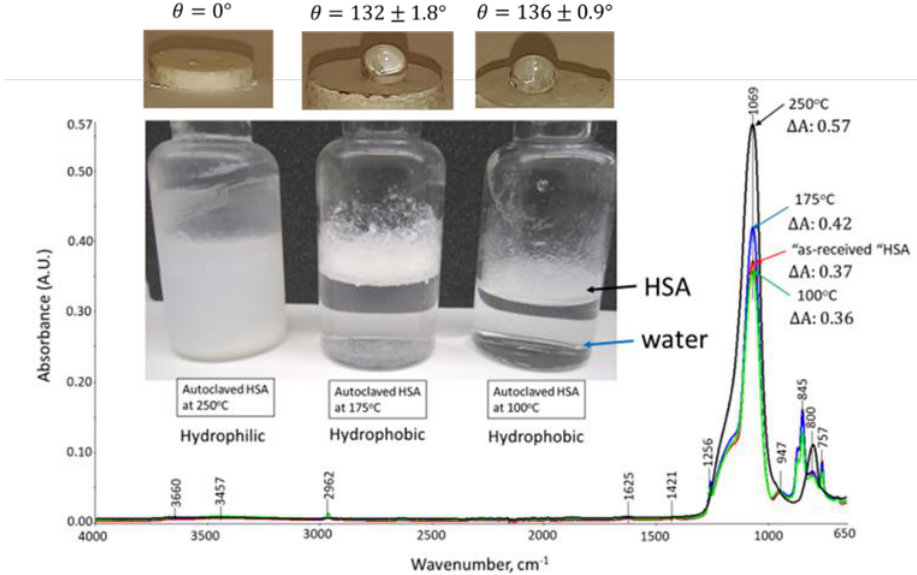
Figure 3. Visual characteristics, water repellency, and ATR-FTIR analyses for 100, 175, and 250 °C- autoclaved HSA.